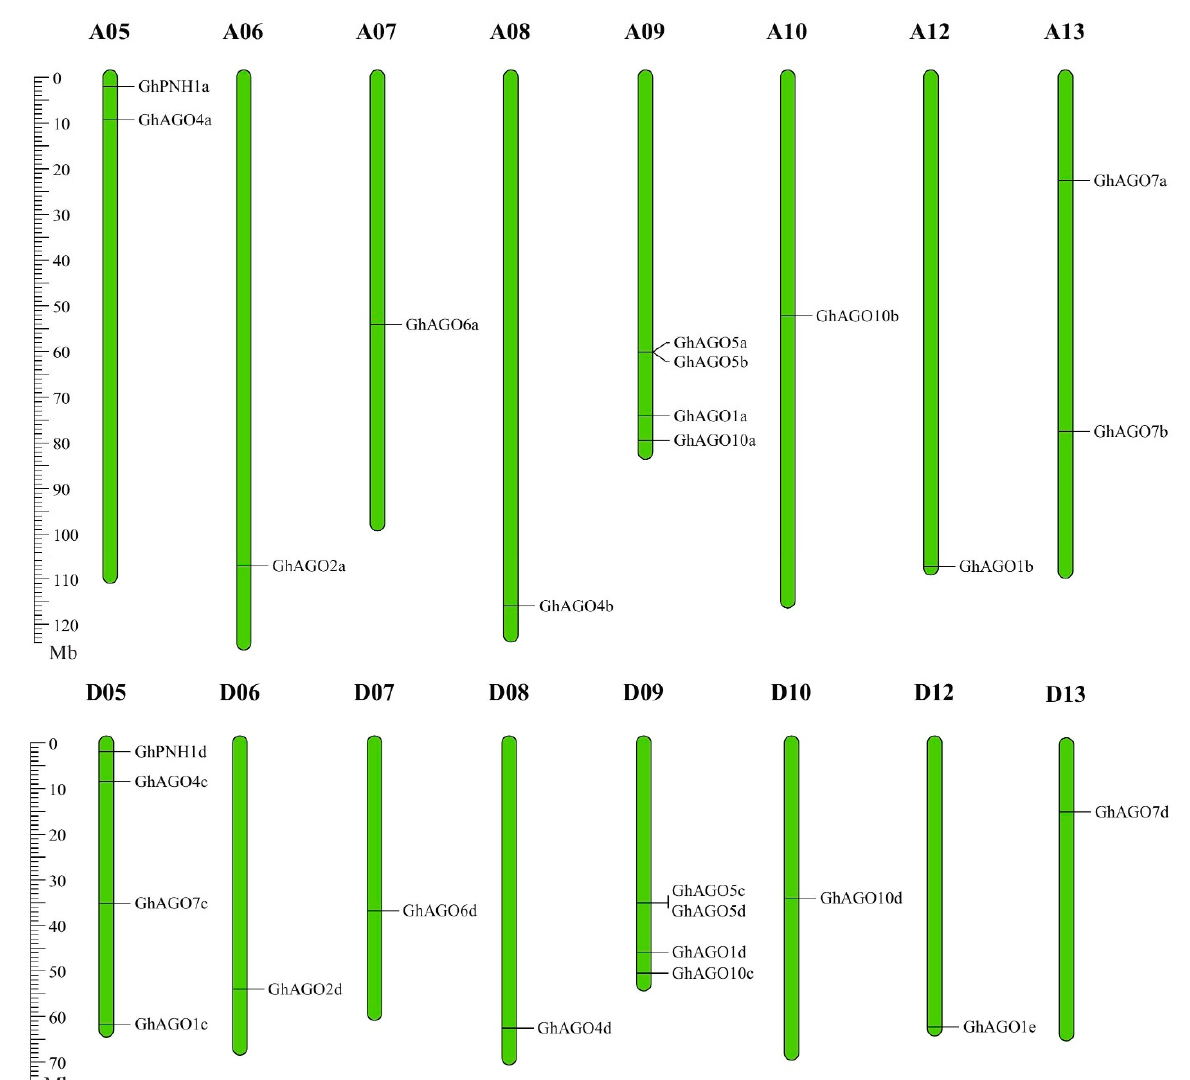
Figure 2. Chromosomal localizations of the GhAGO genes. Green bars indicate the G. hirsutum chromosomes. The scale bar on the left denotes the chromosomal lengths (Mb).